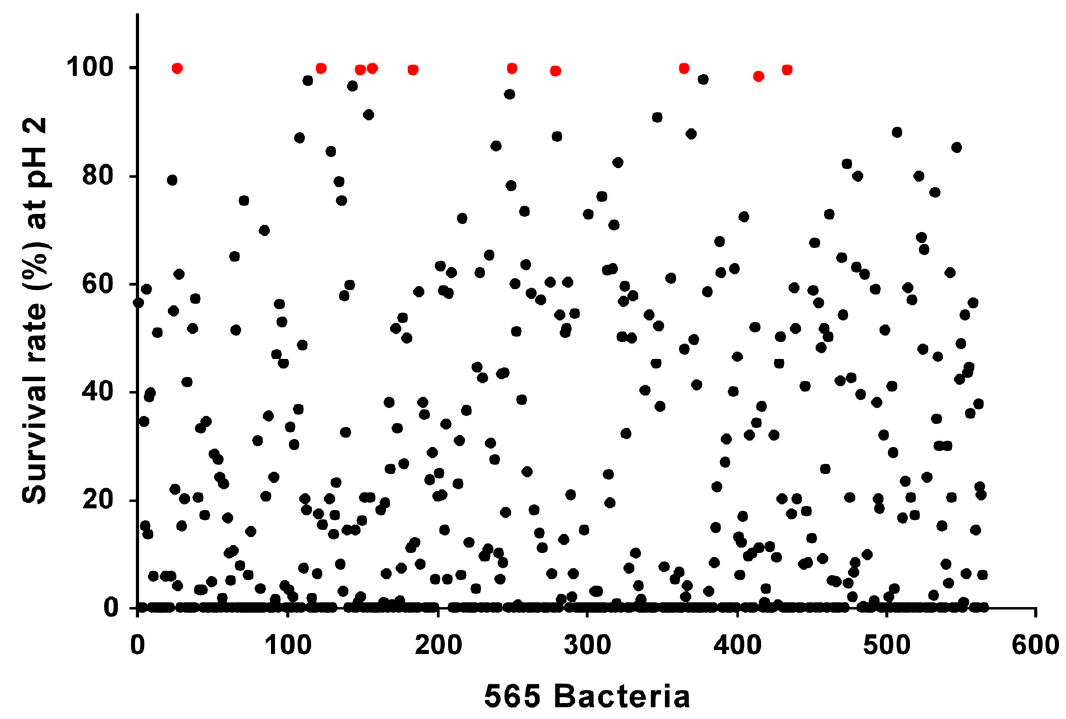
Figure 2. Survival rate of 565 bacteria at pH 2. Red marks show top 10 strains, which have high acid tolerance at pH 2. Table 1. Acid tolerance of 10 selected strains.